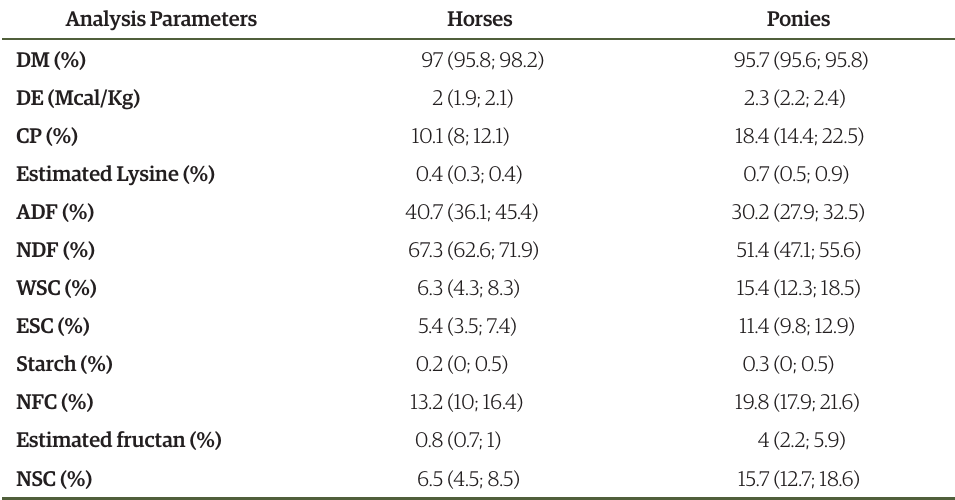
Table 5 . Chemical analysis (on a dry matter basis) of the cool season grass pastures and hay for horses and ponies. Analysis Parameters